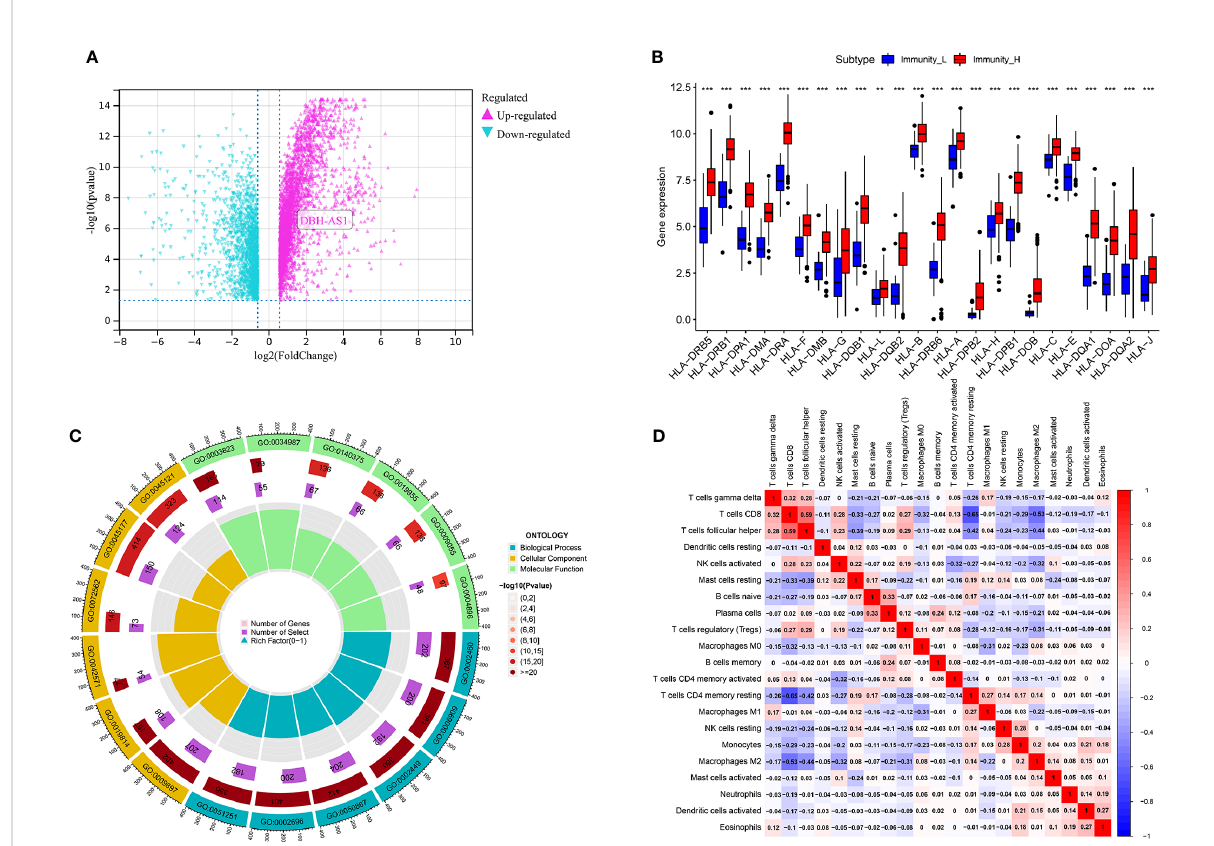
FIGURE 2 (A) The volcano map demonstrates the different expression genes between immune_H and immune_L groups; (B) the different expression level of 24 genes encoding human leukocyte antigens between immune_H and immune_L groups. (C) GO enrichment analysis based of different immune subtypes. (D) The correlation analysis between different immune cells *** P < 0.001; ** P <